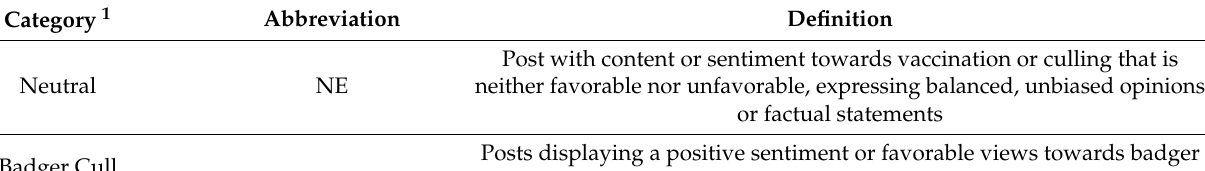
Table 1. Digital and social media post